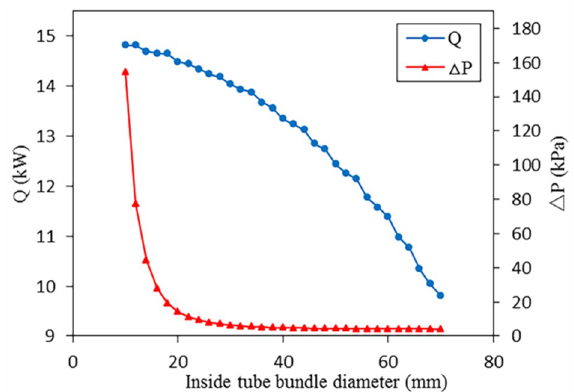
Figure 8. Heat transfer capacity and shell-side pressure drop separately versus inside tube bundle diameter.